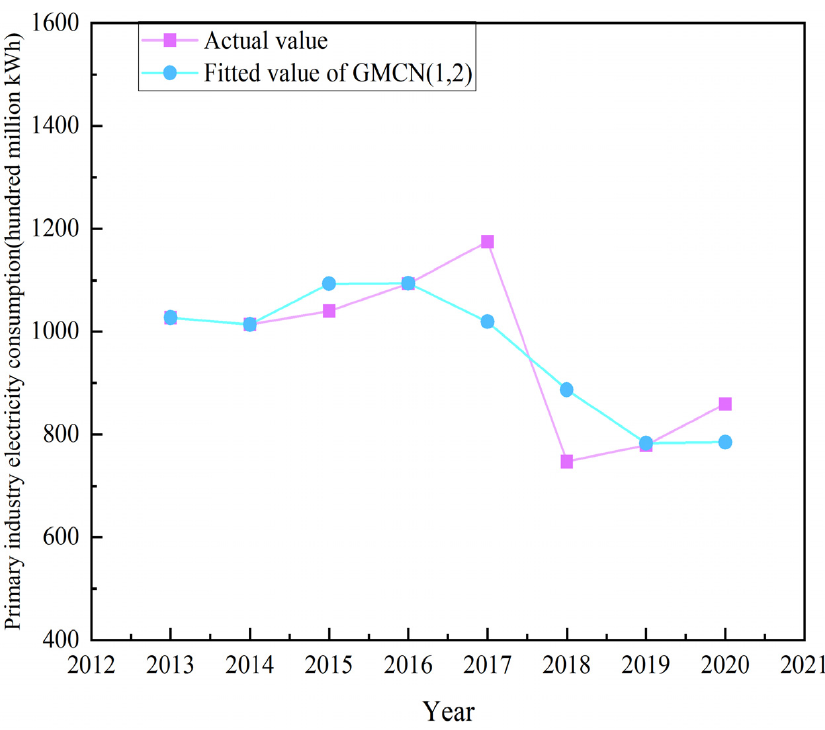
Figure 6. Fitting between predicted and actual values.